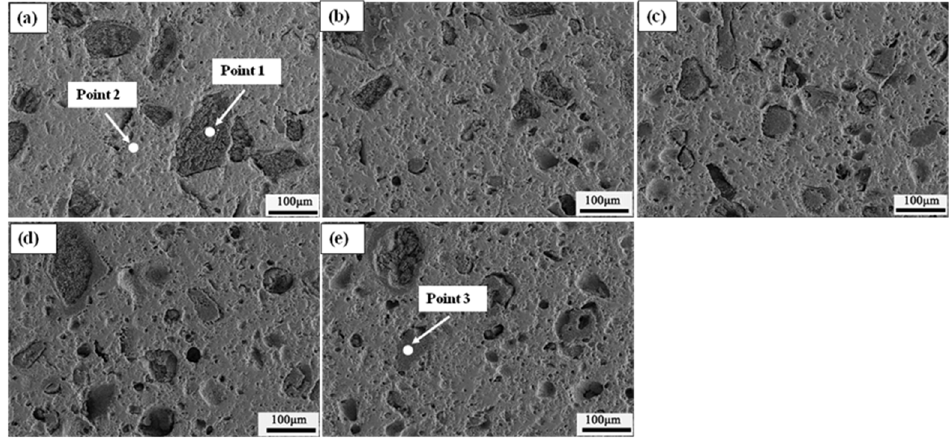
Figure 9. SEM analysis of the sample of Fe 2 O 3 -MgO. ( a ) 0%; ( b ) 25%; ( c ) 50%; ( d ) 75%; ( e ) 100%. Table 5. EDS analysis of Fe 2 O 3 -MgO sample before reduction.